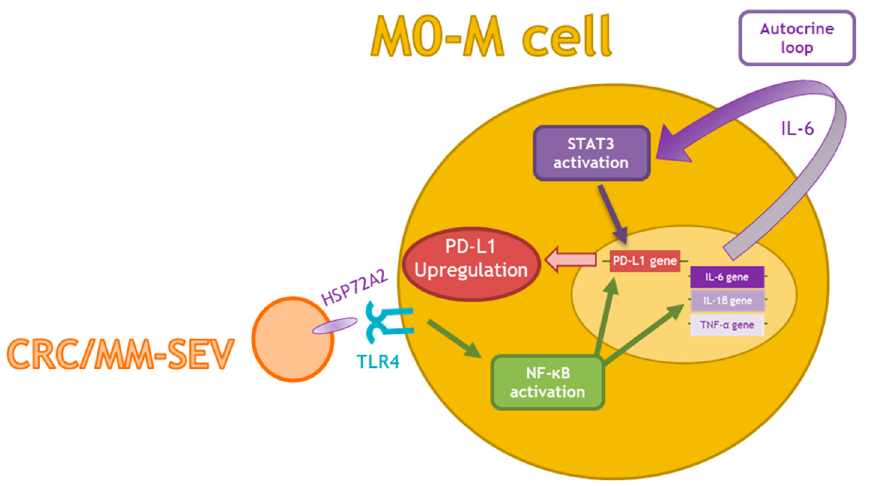
Figure 5. Schematic representation of the proposed model: MM- and CRC-SEVs carry HSP70A2, which can bind TLR4 and in turn activate NF- κ B. NF- κ B enhances the transcription of both PD-L1 and pro-inflammatory cytokines, such as IL-6, IL-1 β , and TNF- α . The increase in IL-6 turns into an autocrine loop that promotes the activation of STAT3, thus leading to an increase in PD-L1